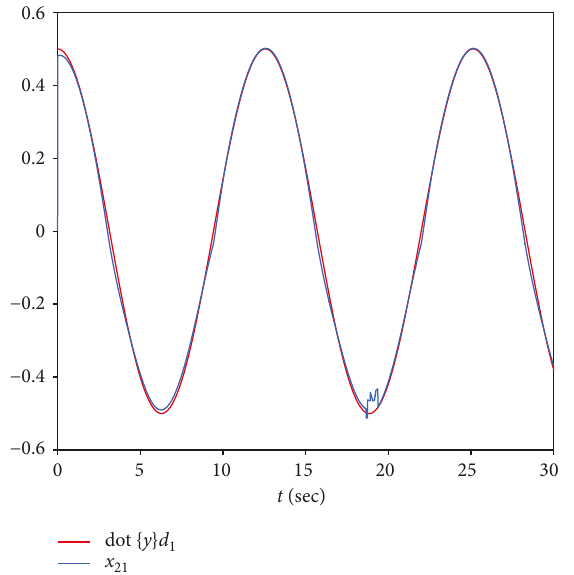
Figure 4: The time response of velocity tracking trajectory of Link 1.